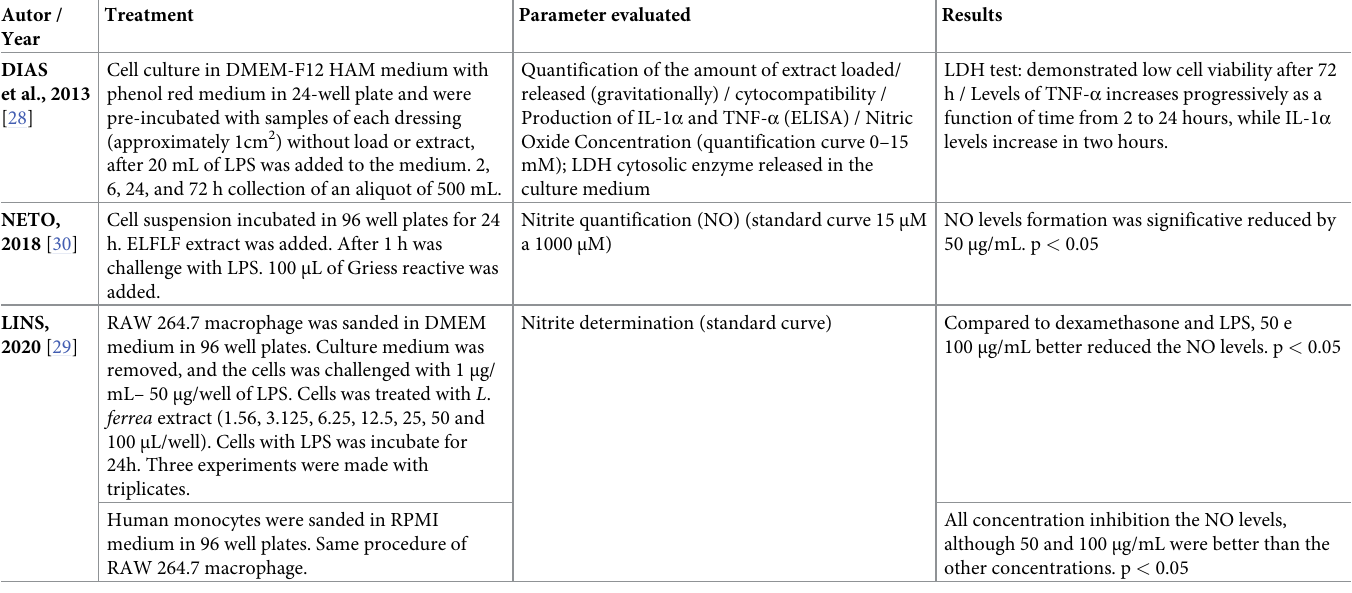
Table 5. Outcome description from the in vitro studies. Autor / Treatment Parameter evaluated Results Year DIAS et al., 2013